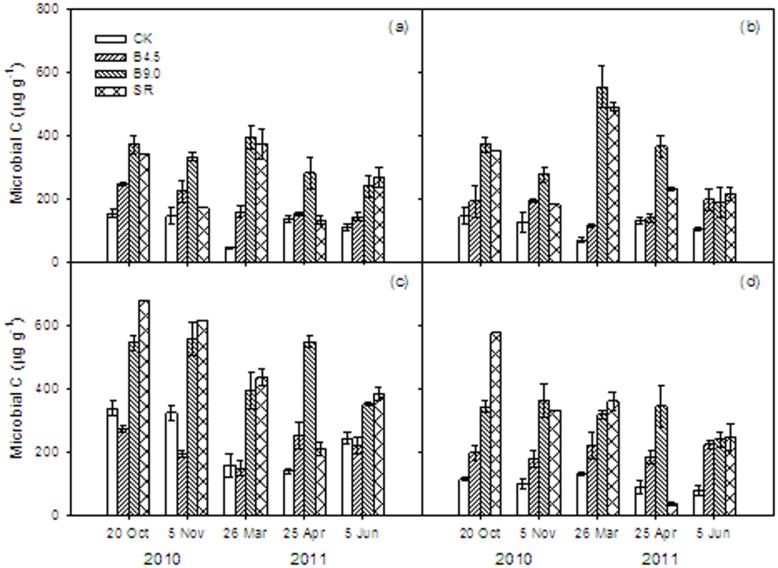
Microbial biomass carbon (MBC) under different treatments (CK: control, B4.5: 4.5 t ha−1 yr−1 biochar addition, B9.0: 9.0 t ha−1 yr−1 biochar addition, SR: incorporation of wheat straw) and different soil depths (a: 0–5, b: 5–10, c: 10–20, and d: 20–30 cm) during winter wheat season.Vertical bars represent the standard errors for means of each treatment (n = 3).